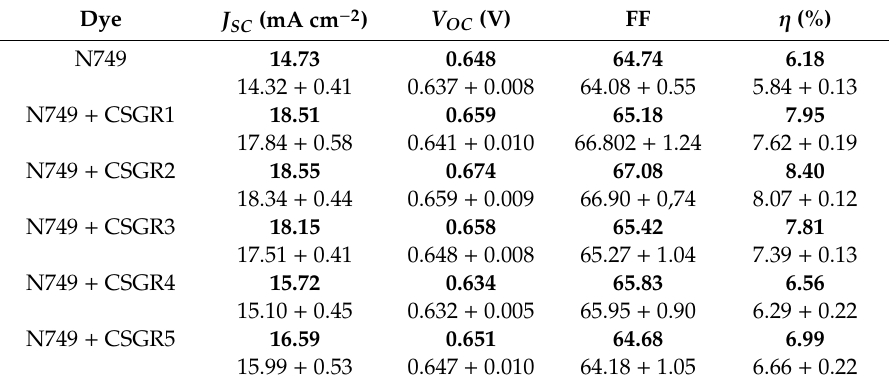
Figure 11. ( a ) IPCE and integrated current density plots and ( b ) are the J - V plots of DSSCs based on N749 dye with CSGR1-5 dyes. Table 2. Photovoltaic measurement data of fabricated DSSC